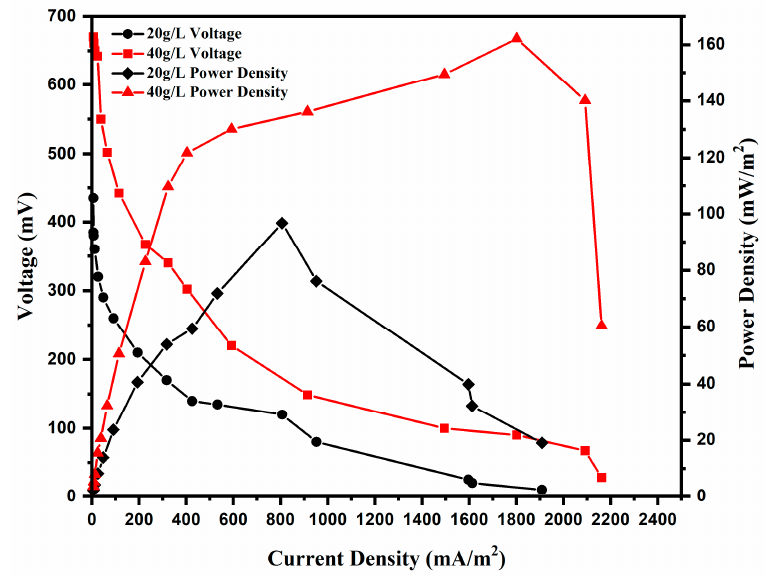
Figure 3. Polarization curves at different salinities.